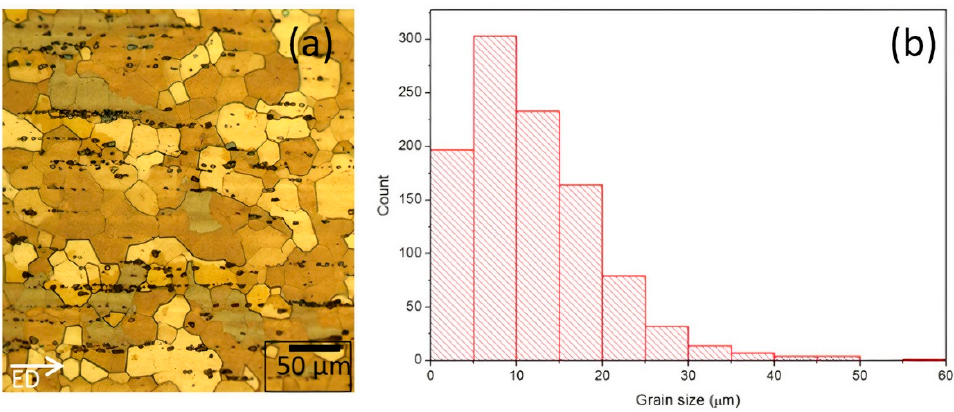
Figure 2. ( a ) Optical microstructure and ( b ) grain size histogram of Mg-2Zn-0.6Ca-1Er.